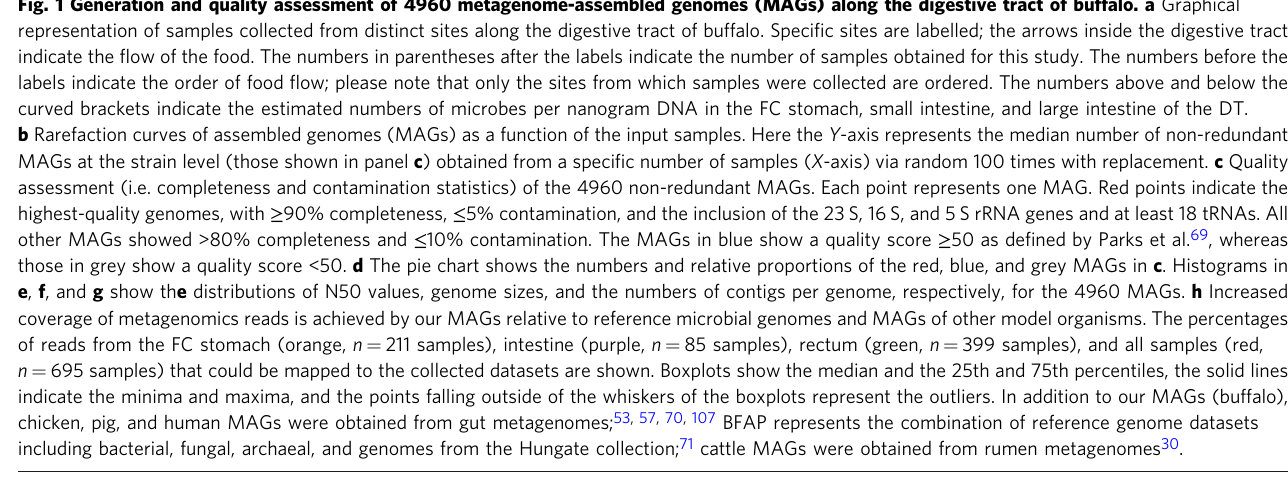
indicate the minima and maxima, and the points falling outside of the whiskers of the boxplots represent the outliers. In addition to our MAGs